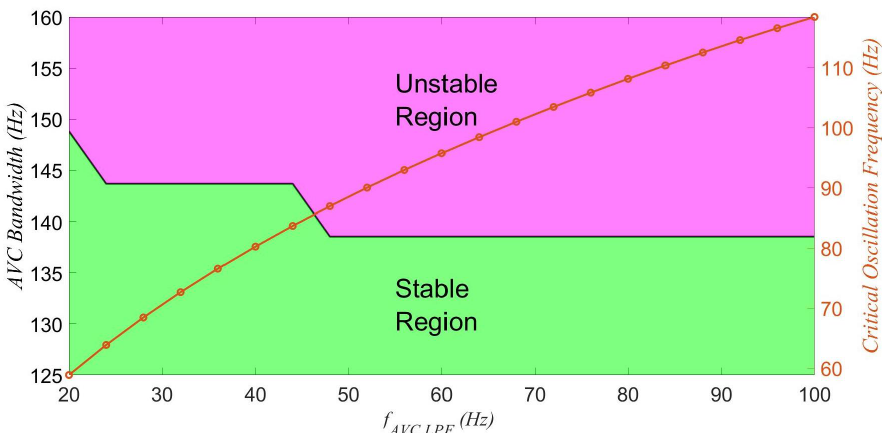
Figure 12. Stability regions of AVC bandwidth in weak grid case (SCR = 1.5), when f AVC,LPF varies from 20 to 100 Hz. The corresponding critical oscillation frequency to the critical AVC bandwidth is shown (red).